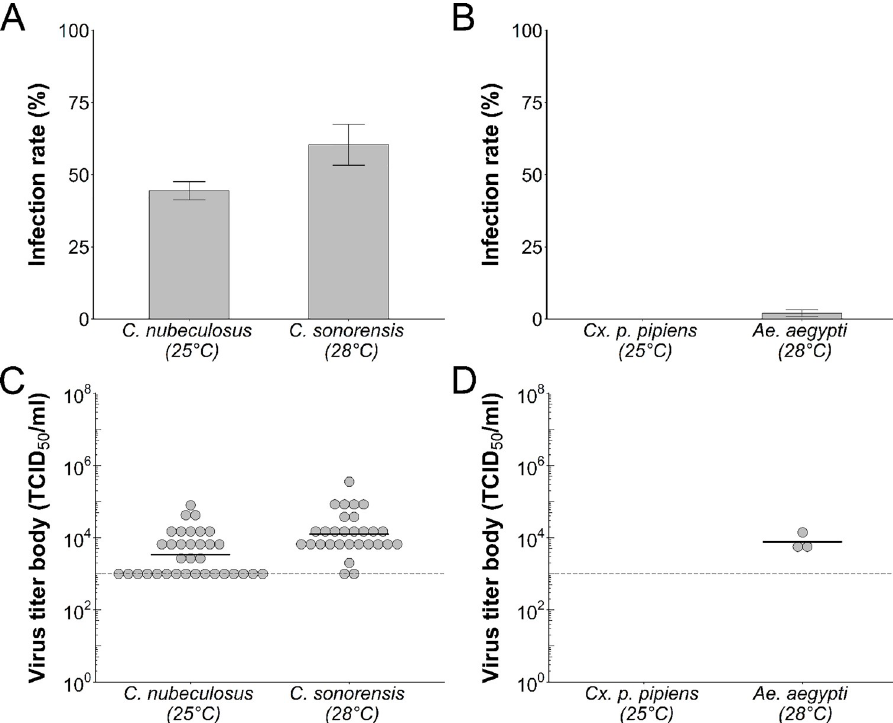
Fig 2. Infection rates and virus titers of biting midges and of mosquitoes exposed to Shuni virus (SHUV) via an infectious blood meal. (A-B) Mean infection rates of Culicoides nubeculosus (N = 243, 25˚C) and C . sonorensis (N = 48, 28˚C; panel A), and Culex pipiens pipiens (N = 211, 25˚C) and Aedes aegypti (N = 149, 28˚C; panel B) orally exposed to SHUV after 10 days of incubation at the respective temperatures. Infection rates are presented as the percentage of virus-positive females out of the total number of blood-fed females that remained alive at the end of the incubation period. Error bars indicate the SEM. (C-D) SHUV titers of virus-positive bodies of C . nubeculosus (N = 34, 25˚C) and C . sonorensis (N = 29, 28˚C; panel C), and Ae . aegypti (N = 3, 28˚C; panel D) after 10 days incubation at the respective temperatures. Each dot represents one individual female, and the black bar indicates the mean. The detection limit of the endpoint dilution assay is indicated with the dashed